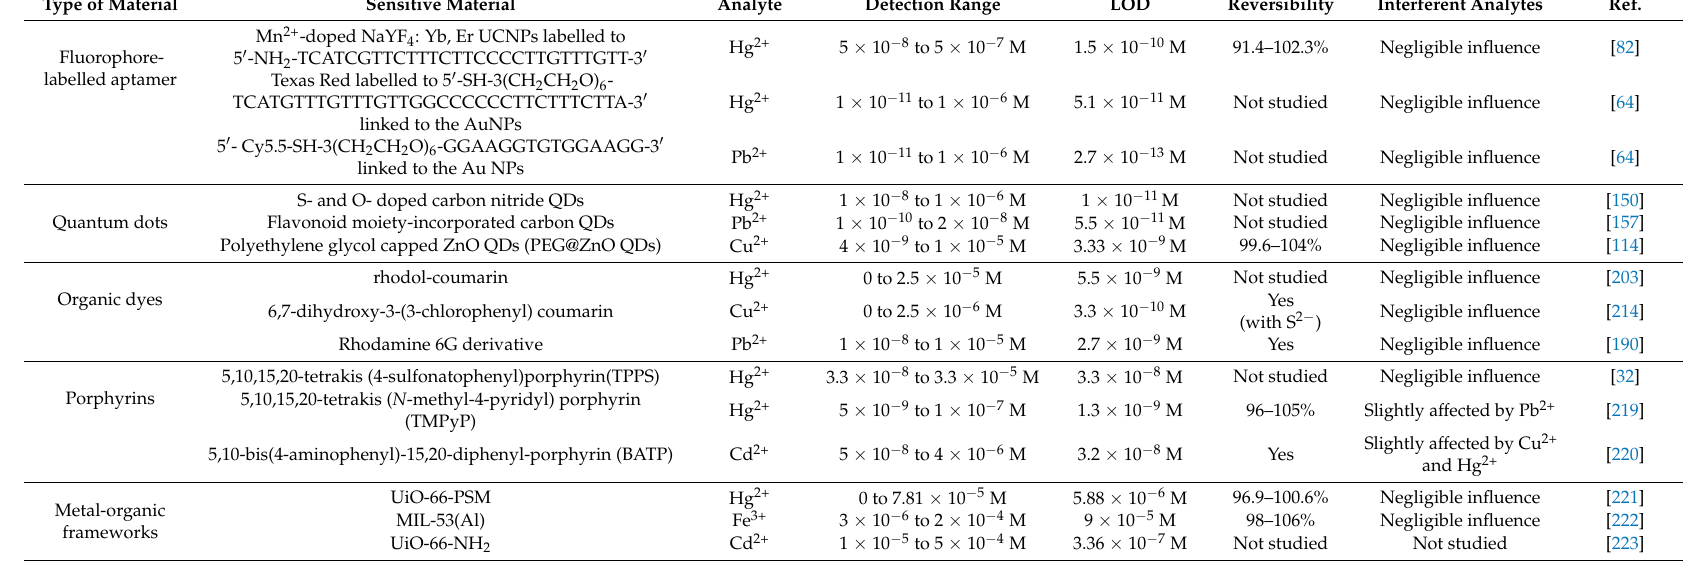
Table 7. Fluorescent sensors for heavy metal ions based on different kind of